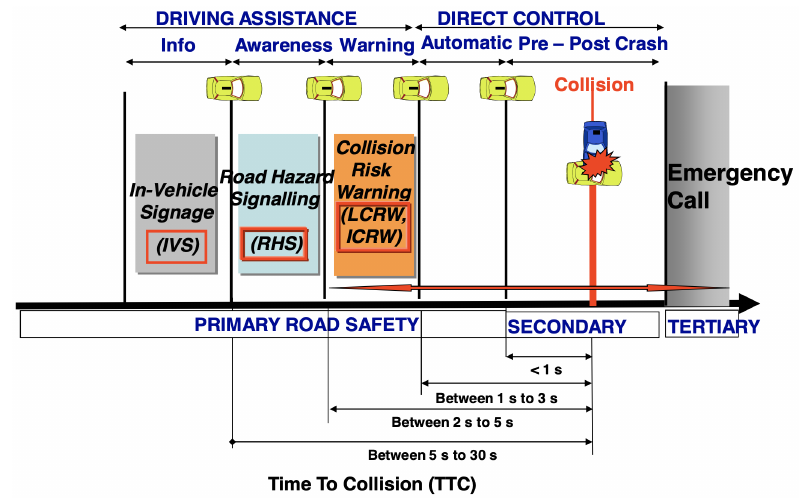
Figure 2. Applications being served by transmission showing the time to collision